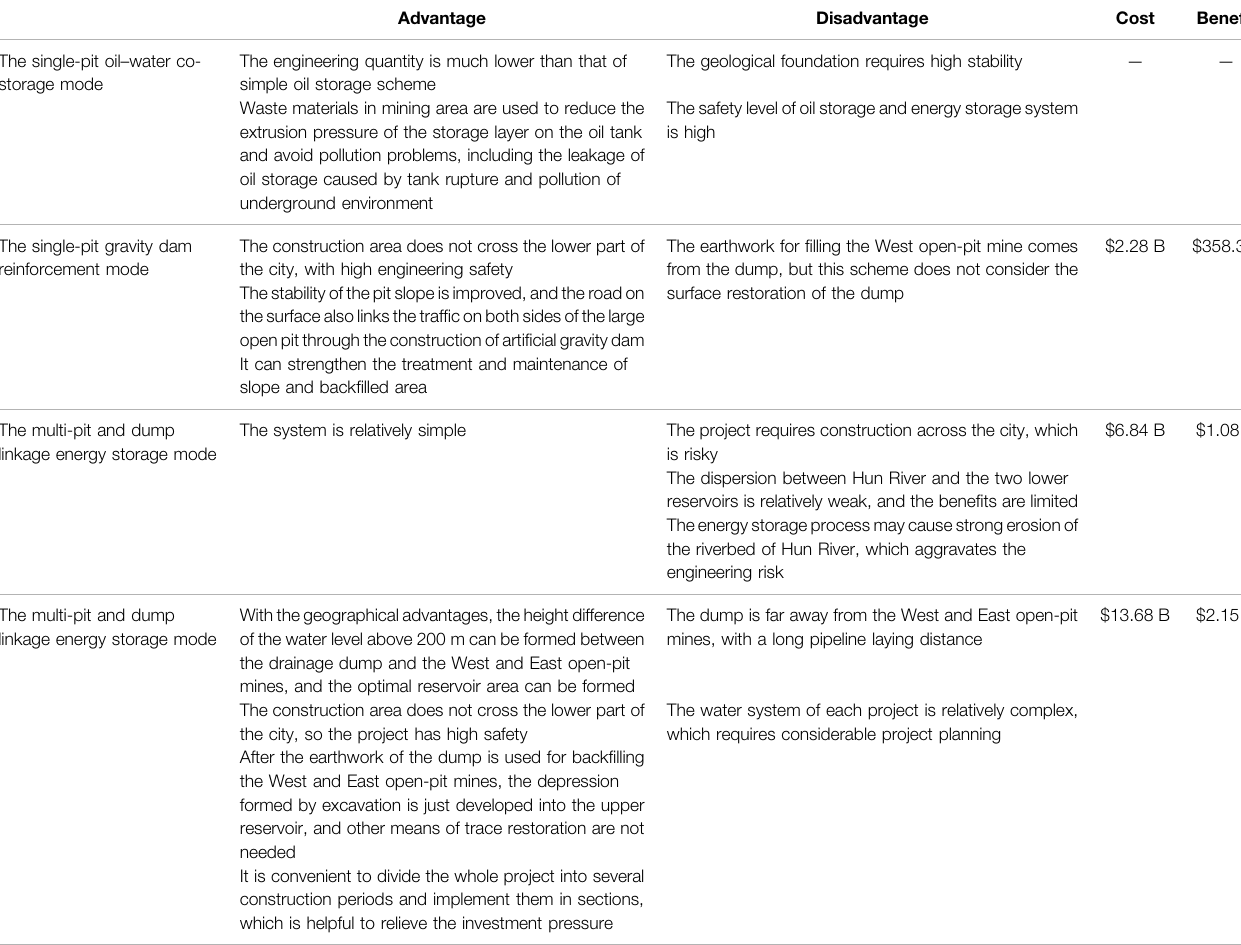
TABLE 1 | Advantages and disadvantages of project implementation of PHES of abandoned open